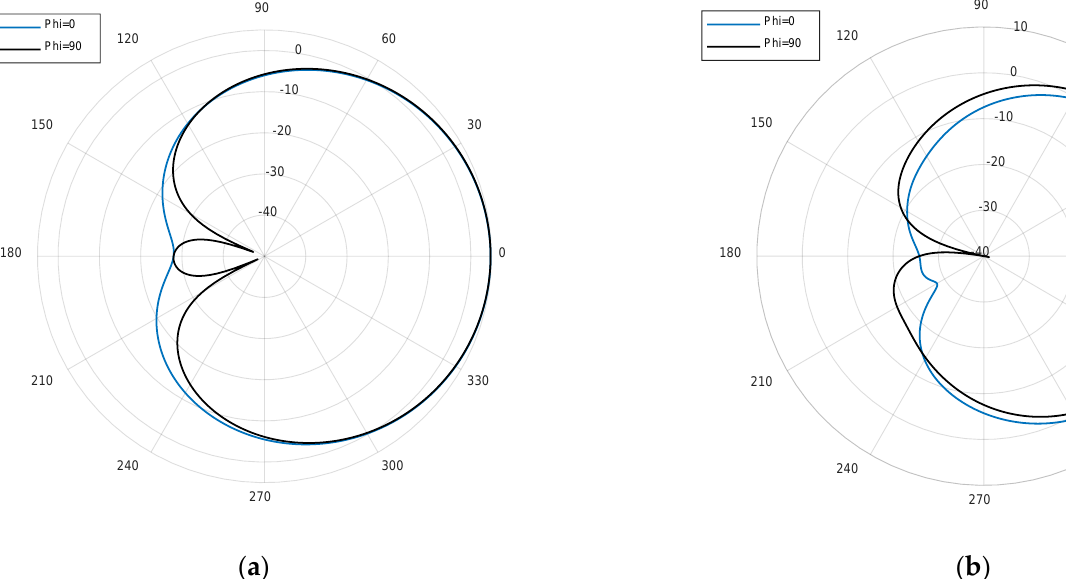
Figure 7. Simulated realized gain (dB) for two perpedicular planes at the central frequency ( a ) RHCP at 1.574 GHz; ( b ) LHCP at 2.44 GHz. The results correspond to Antenna 3.